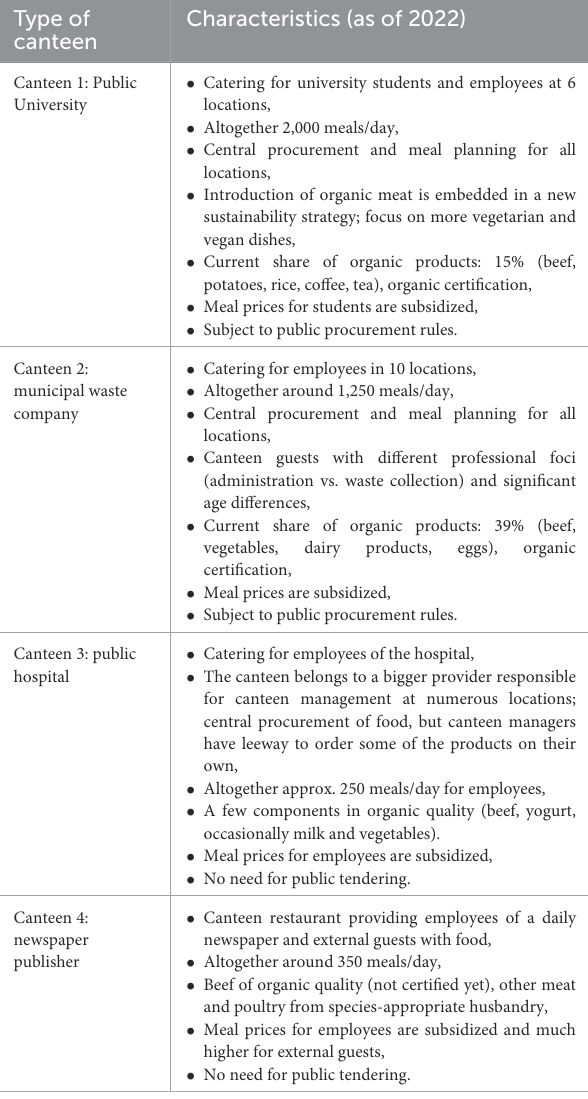
TABLE 1 Characteristics of the participating